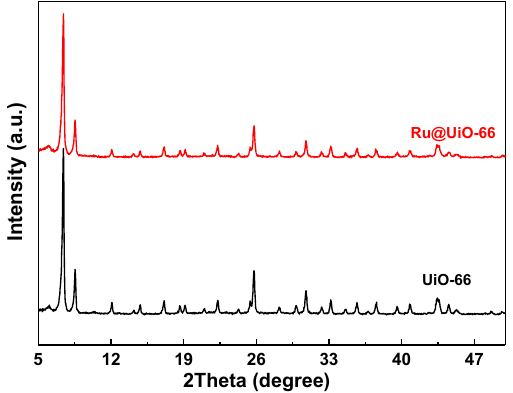
Figure 2. X-ray diffraction (XRD patterns of Ru@UiO-66 and UiO-66. Figure 2. X-ray di ff raction (XRD patterns of Ru@UiO-66 and